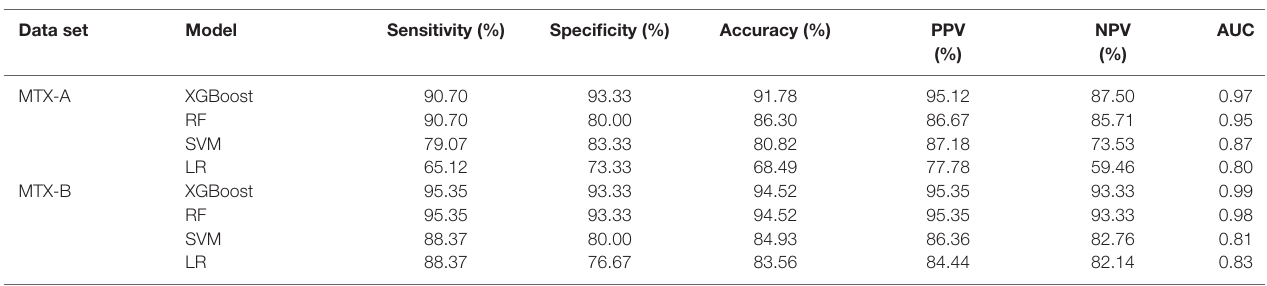
TABLE 3 | The classification performance results of the